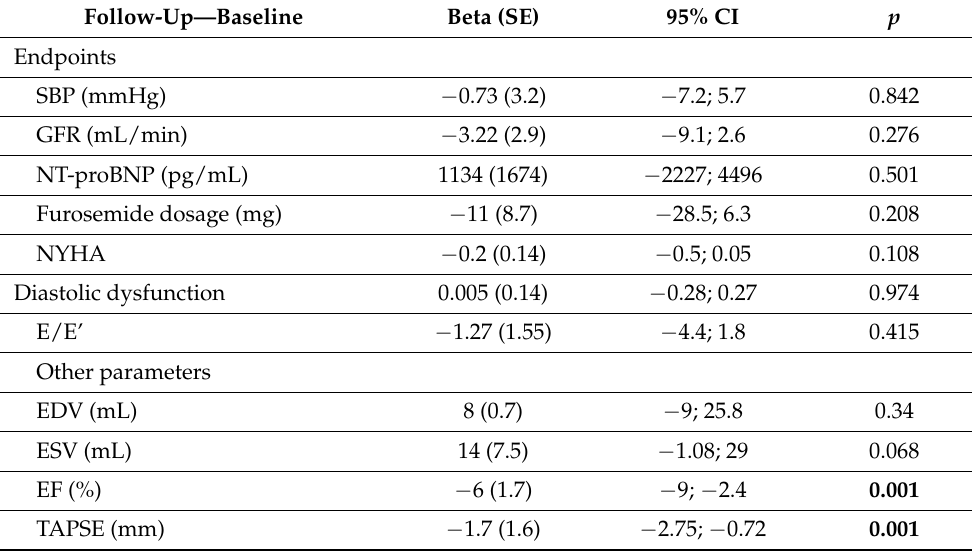
Table 3. Results of linear regression. A significant improvement of EF and TAPSE was observed in non-ischemic vs ischemic groups. The beta coefficient expresses the increase (if >0) or decrease (if <0) estimated for each delta, moving from the non-ischemic group (reference category for comparison) to ischemic. SE = standard error, CI = confidence interval, SBP = systolic blood pressure, GFR = Glomerular filtration rate, NYHA = New York Hearth Association, EDV = end diastolic volume, ESV = end systolic volume, EF = ejection fraction, TAPSE = tricuspid annular plane systolic excursion. Bold values are statistically significant.